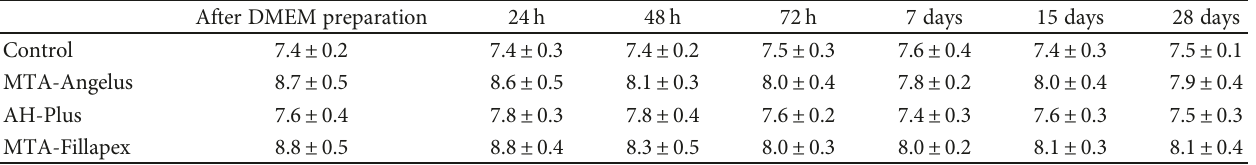
Table 2: Mean and standard deviations of the pH value for preconditioned medium at the di ff erent time periods. After DMEM